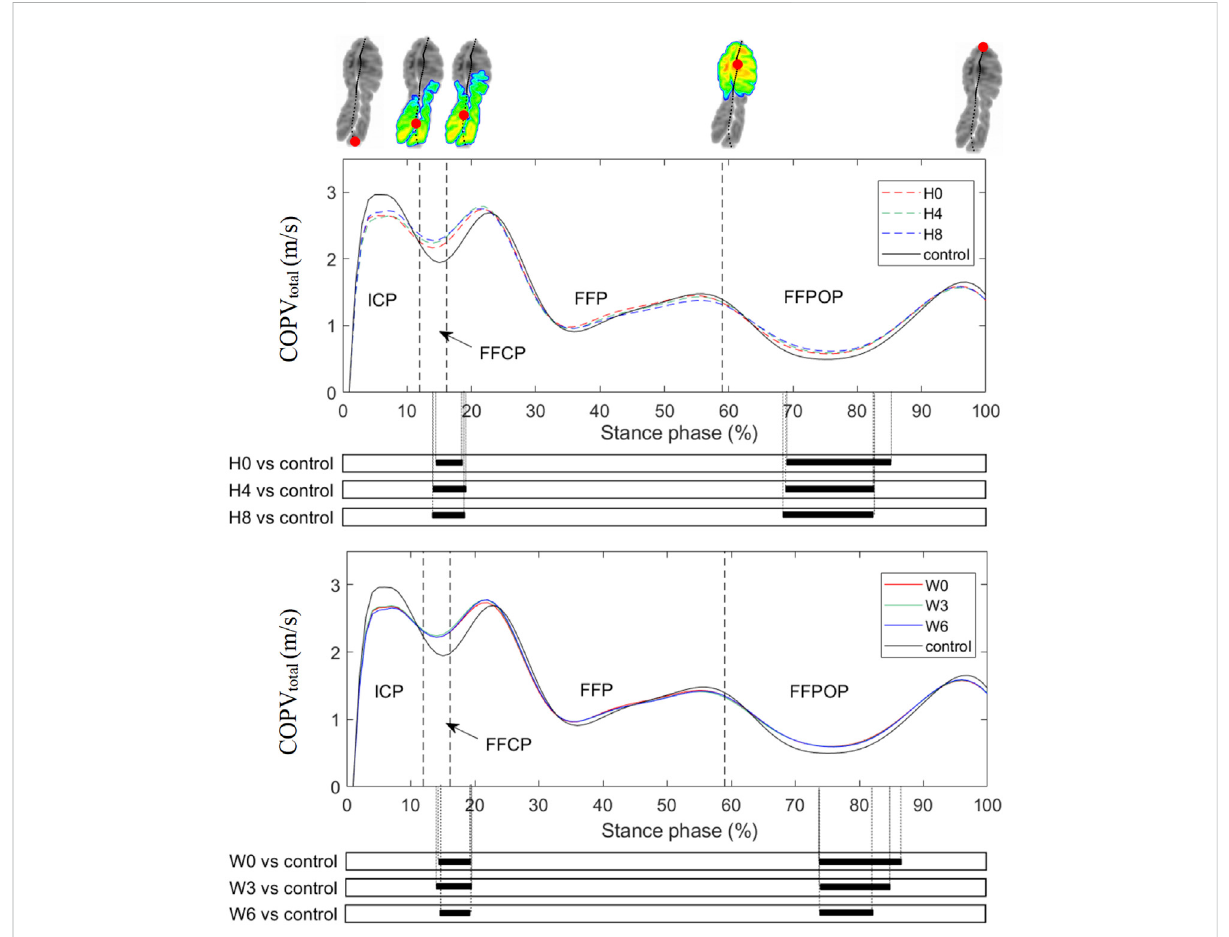
FIGURE 4 Mean curves of the COPV total during running. H0, H4, and H8 represented the mean data of arch supports of three different heights; W0, W3, and W6 represented the mean data of arch supports of three different widths. Four sub-phases are indicated with vertical lines on the x -axis. The black bar below the graph represents thetime during whichthe differences between thegroups occurred ( p < 0.05), what was indicated by the SPM {t} statistics. ICP, initial contact phase; FFCP, forefoot contact phase; FFP, foot fl at phase; FFPOP, forefoot push off phase; IFC, initial foot contact; IMC, initial metatarsal contact; FFC, forefoot contact; HO, heel-off; TO,